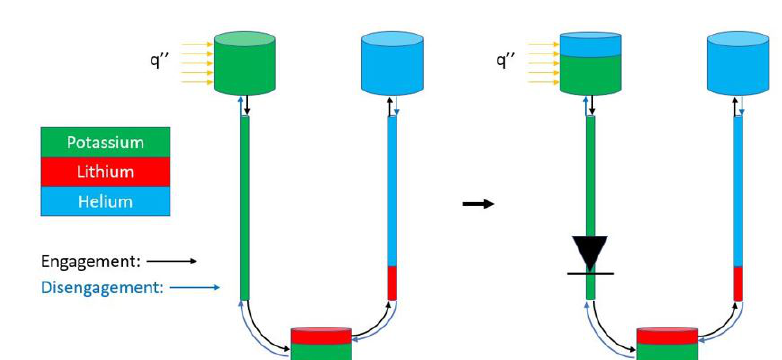
Figure 1: Abstraction of the ARC system (left) and its modification to include the one-way valve and cover gas